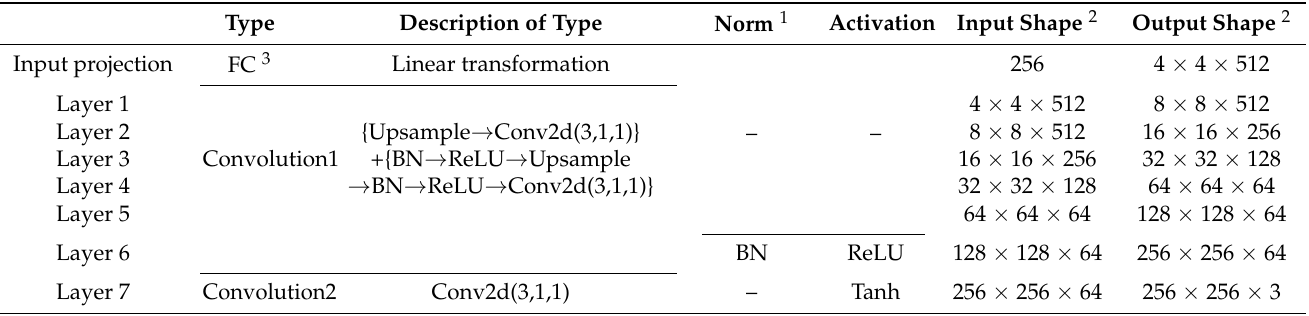
Table 1. Generator architecture of CR-GAN for 256 × 256 image